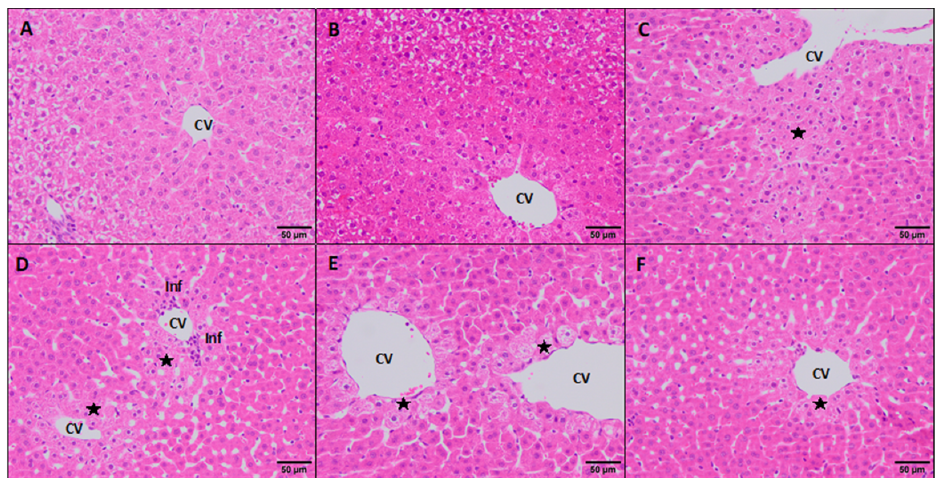
Figure 6. Histopathological changes in the liver of rats exposed to PTS. ( A – C ) Controls (negative, solvent, and positive, respectively); ( D – F ) PTS doses (55.0, 17.4, and 5.5 mg/kg, respectively). He- matoxylin and eosin stain. CV: central vein; *: degenerated hepatocytes; Inf: inflammatory infil- trates.